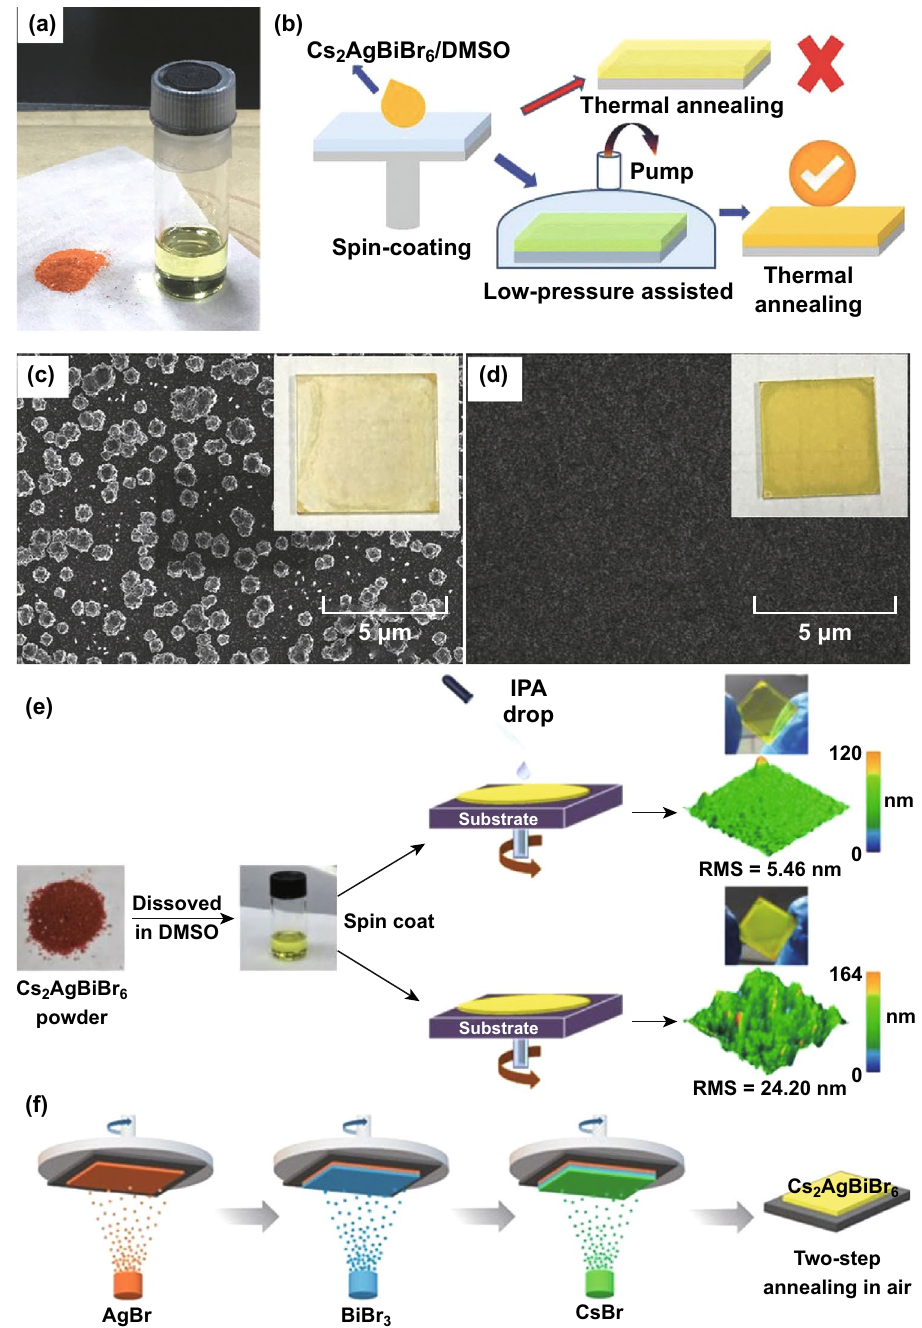
Fig. 7 a Image of Cs 2 AgBiBr 6 powder (left) and solution in DMSO (right). b The film fabrication process diagram. c, d SEM images of film obtained by traditional thermally annealed and low-pressure-assisted process, respectively, inset: film photograph, size, 25 × 25 mm 2 . Repro- duced with permission from Ref. [97]. e Schematic illustration of the spin-coating process with and without anti-solvent dropping protocol; the morphology of the as-prepared film can be improved after IPA dropping. Reproduced with permission from Ref. [98]. f Scheme of sequential vapor deposition processing of Cs 2 AgBiBr 6 double perovskite. Reproduced with permission from Ref.